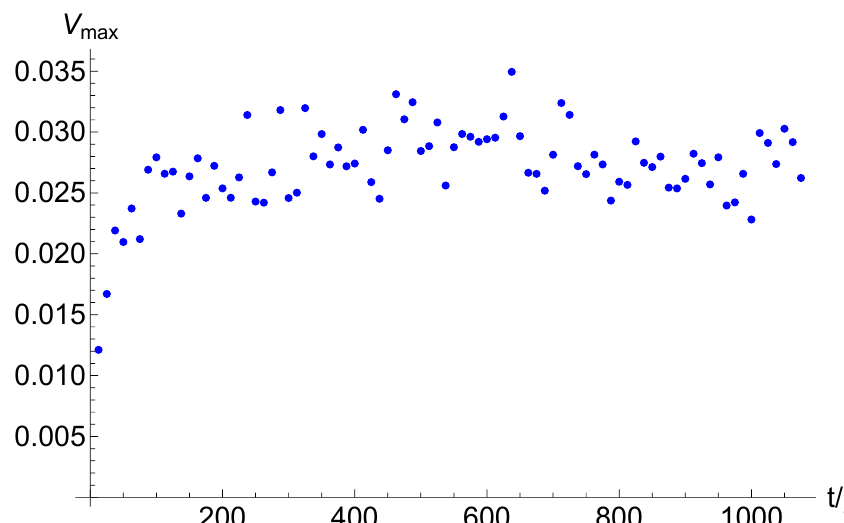
Figure 3 . Maximal values of the velocity field (relative to the speed of light) as a function of time for a single run (no ensemble